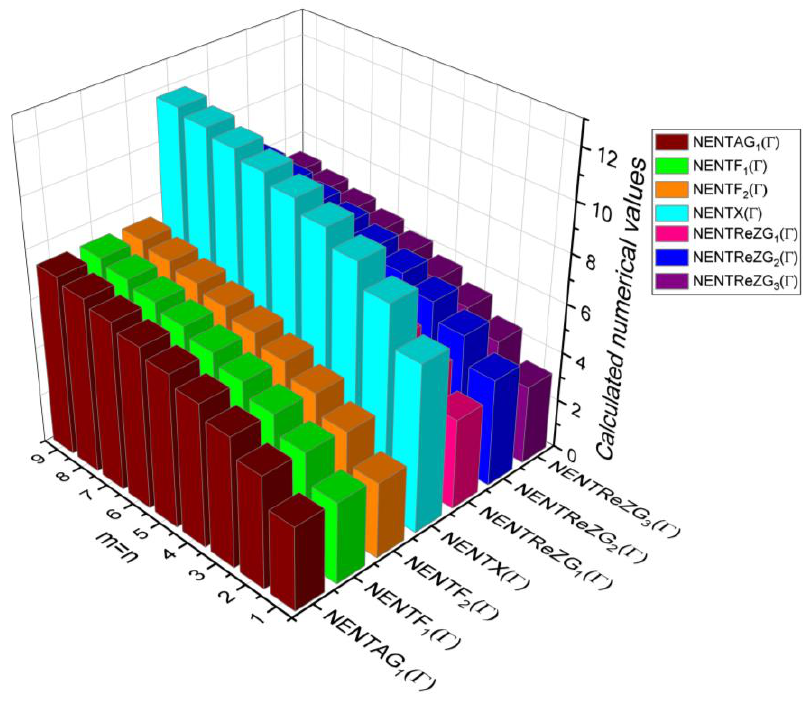
Figure 6. 3D Plots for Table 6. Table 5. Comparison Table for Theorem 3.